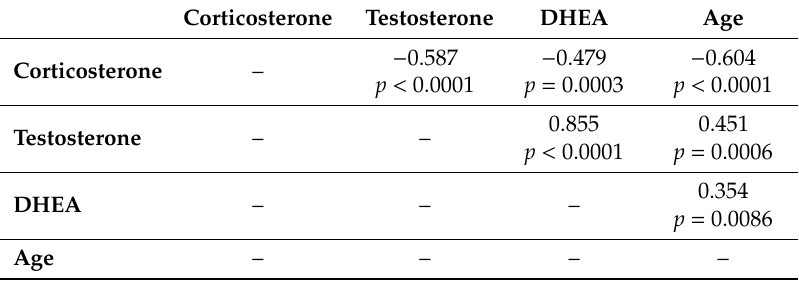
Table 1. Spearman rank correlation matrix.